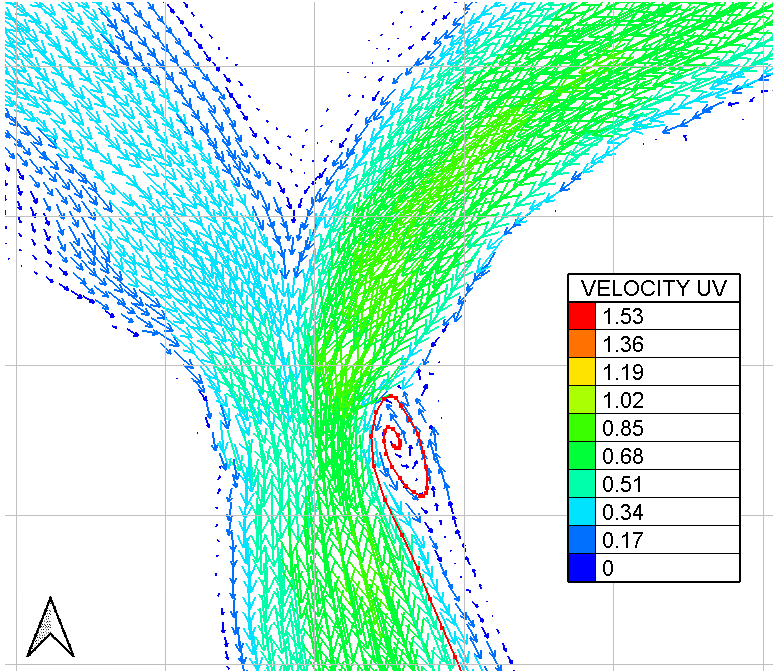
Figure 7. Average flow velocity (VELOCITY UV) in the flood season in 2018 (m/s).